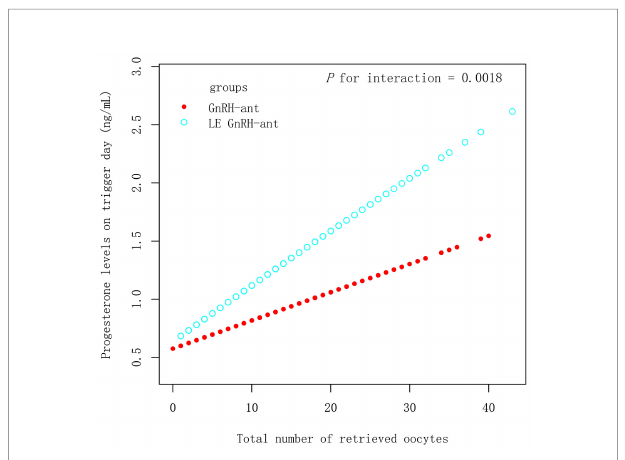
FIGURE 2 | Relationship between progesterone levels and the number of retrieved oocytes in GnRH-ant and LE GnRH-ant groups. GnRH-a: gonadotropin- releasing hormone-agonist; GnRH-ant: gonadotropin-releasing hormone- antagonist; P1.5: the proportion of women with a progesterone level >1.5